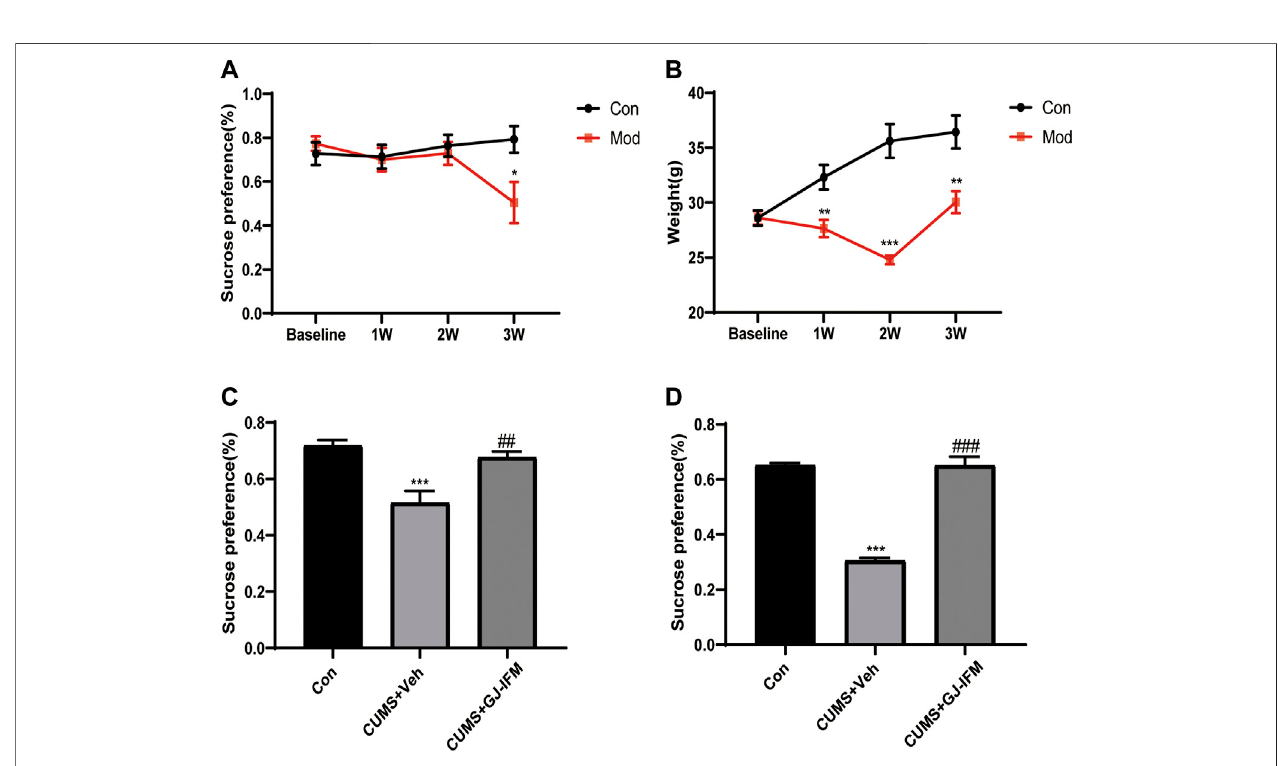
FIGURE7| TheeffectsofasingledoseofGJ-IFM(100 mg/kg)inCUMSmiceonSPTandbodyweight. (A) SPTafter3 weeksofCUMSadministration. t -test,* p < 0.05;control vs .CUMS+vehicle. (B) Bodyweightafter3 weeksofCUMSadministration. t -test,** p < 0.01,*** p < 0.001;control vs .CUMS+vehicle. (C) Theeffectsofa single dose of GJ-IFM (100 mg/kg) treatment in CUMS mice on SPT at 1 d. One-way ANOVA, *** p < 0.001; control vs . CUMS + vehicle; ## p < 0.01; CUMS +vehicle vs . CUMS + GJ-IFM. (D) The effects of a single dose of GJ-IFM (100 mg/kg) treatment in CUMS mice on SPT on 10 d. One-way ANOVA, *** p < 0.001, control vs . CUMS + vehicle; ### p < 0.001, CUMS + vehicle vs . CUMS + GJ-IFM.